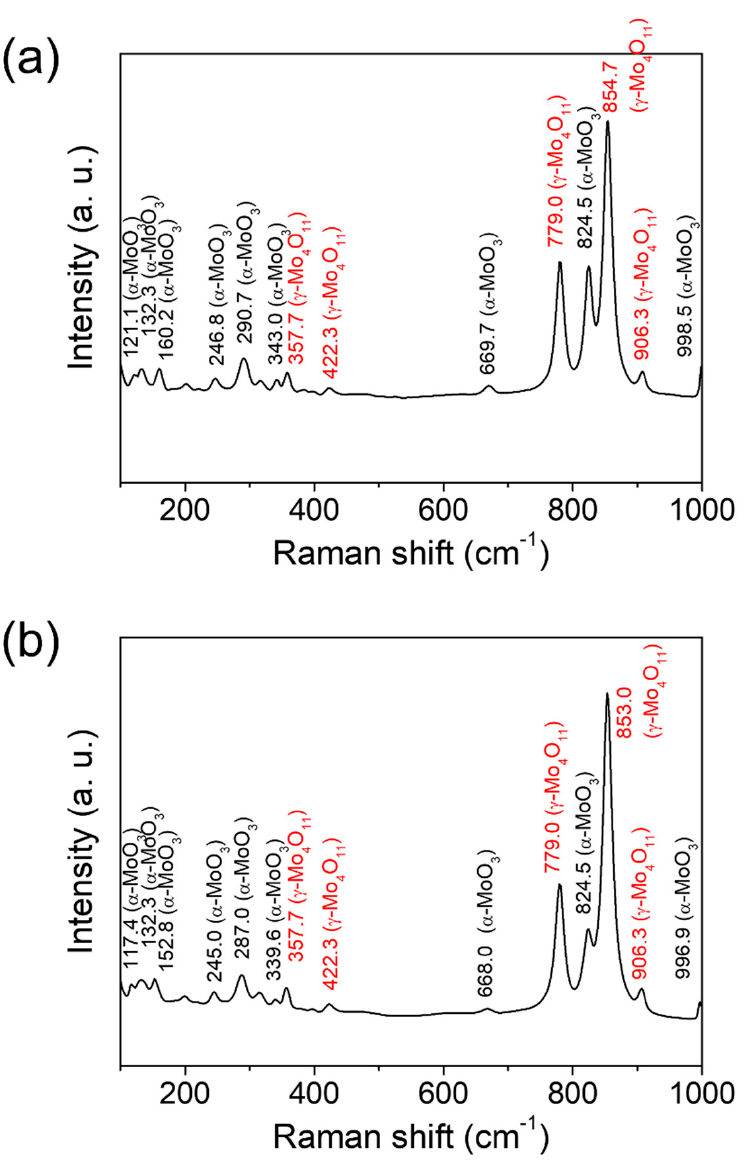
Figure 5. Raman spectra of the molybdenum oxide nanoparticle aggregates prepared on CFP substrates by the CVT method using two different types of precursors: ( a ) MoO 3 and ( b ) 1:1 (mol/mol) mixture of MoO 3 and activated carbon.